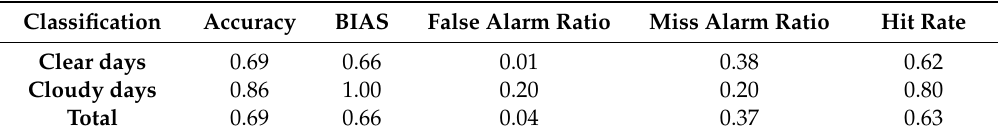
Figure 11. Contingency tables for clear ( left ) and cloudy sky days ( right ) for forecasted values. Table 13. Evaluation of algorithm performance in the ice alert code forecast for Linate Airport: forecasted values assumed by the indices.